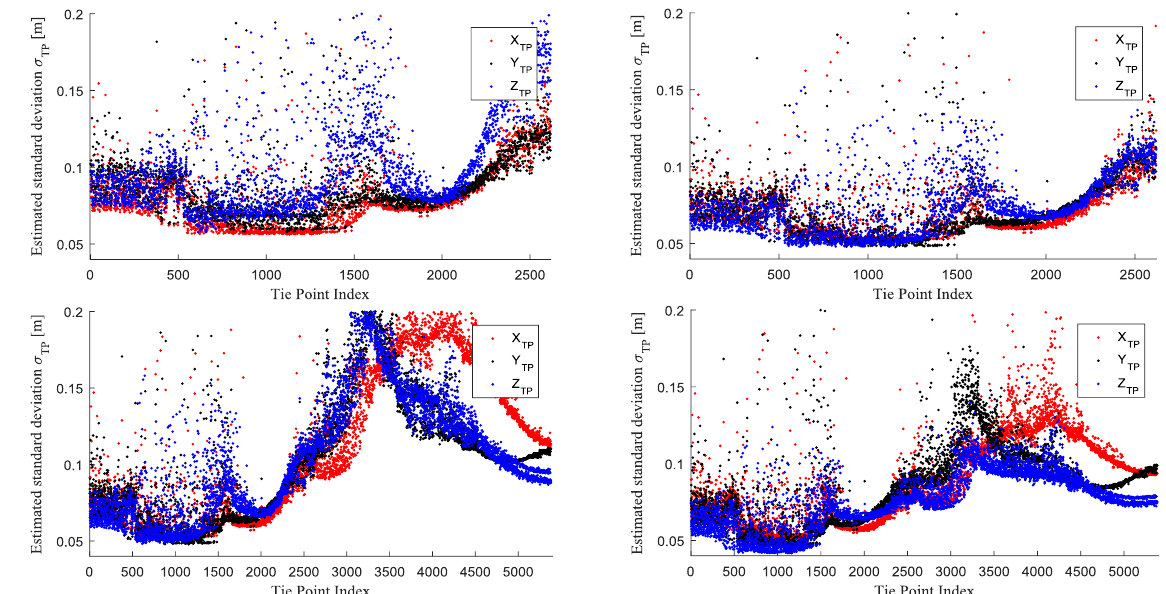
Figure 7: A-posteriori standard deviations of the tie point coordinates in object space after steps 2 (top left), 4 (top right), 5 (bottom left) and 6 (bottom